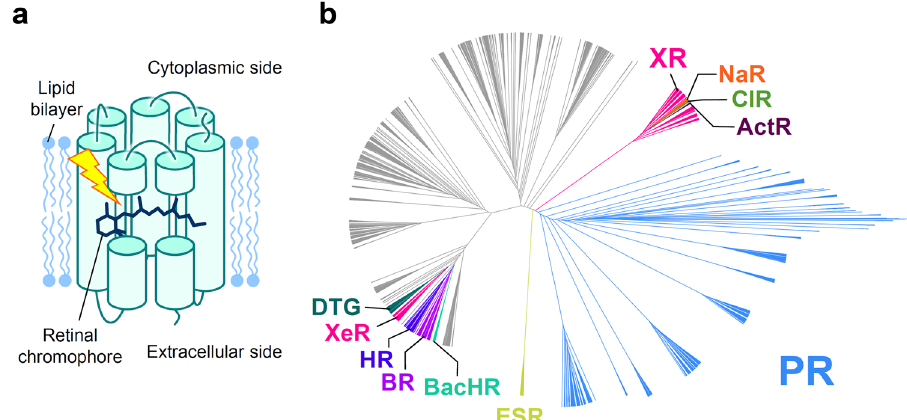
Fig. 1 Structure and phylogenetic tree of microbial rhodopsins. a Schematic structure of microbial rhodopsins. b Phylogenic tree of microbial rhodopsins. The subfamilies of light-driven ion-pump rhodopsins targeted in this study are differently colored; non-ion-pump microbial rhodopsins and ion-pumping microbial rhodopsins from eukaryotic and giant viral origins are shown in